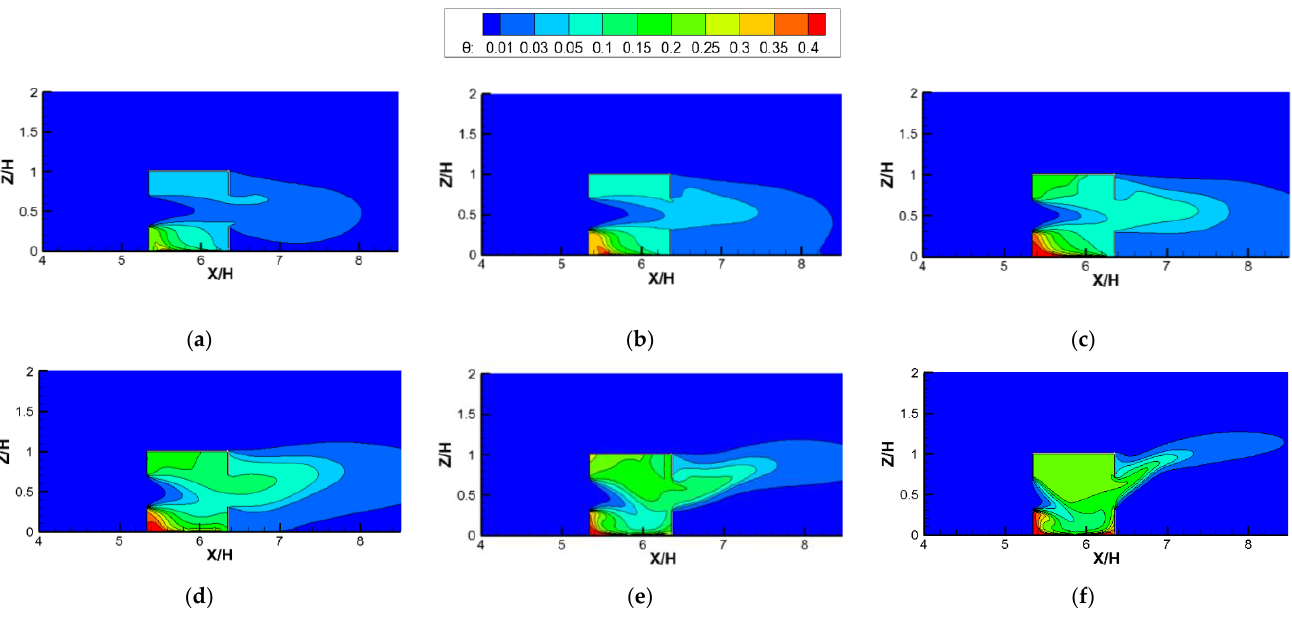
Figure 11. Contours of dimensionless temperature ( θ ) against increasing Ri numbers for cross-ventilation cases. ( a ) Ri = 0.04; ( b ) Ri = 0.27; ( c ) Ri = 1.86; ( d ) Ri = 5.31; ( e ) Ri = 11.11; ( f ) Ri = 26.65.